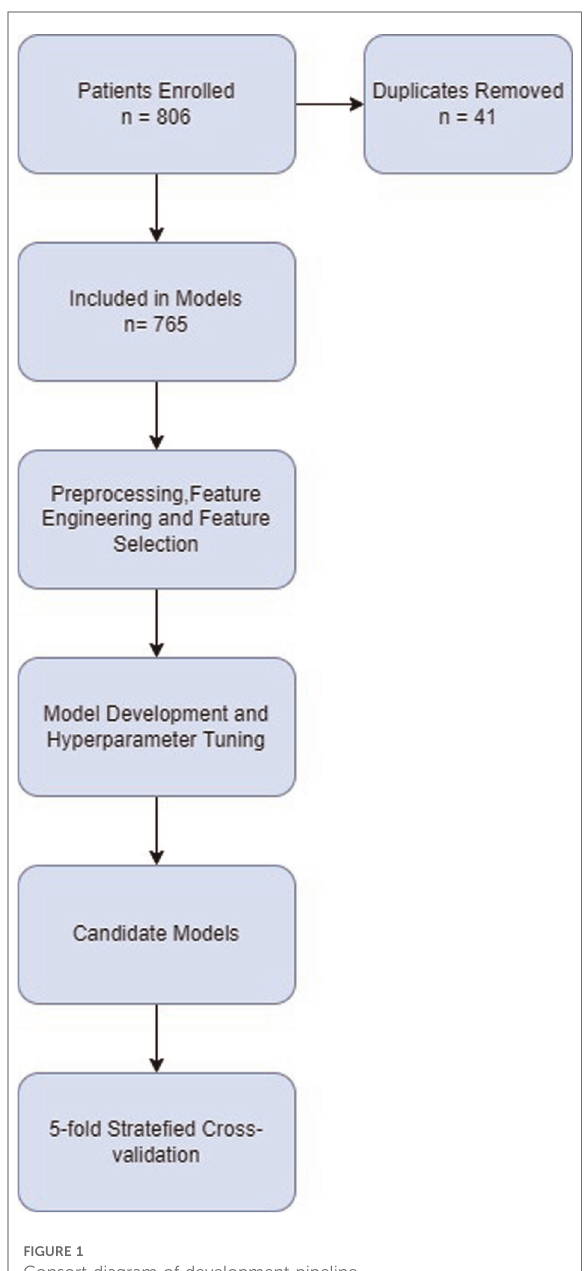
FIGURE 1 Consort diagram of development